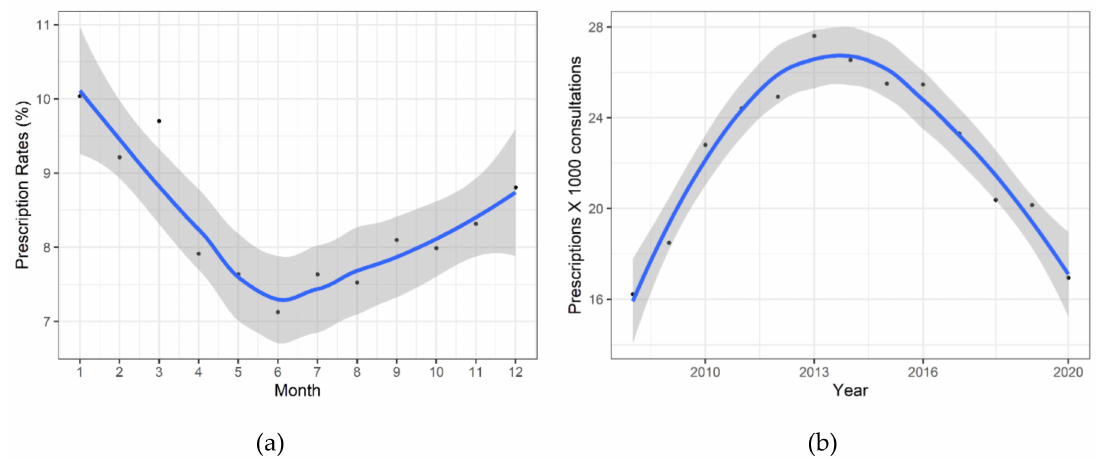
Figure 3. Distribution of antibiotic prescribing in Swiss primary care. Points are observed numbers and lines are smoothed curves; 95% Confidence Interval band is shown in grey. ( a ) Seasonal variation of antibiotic prescriptions by month: 1 = January, 12 = December; ( b ) Fluctuation of antibiotic prescriptions over 12 years.